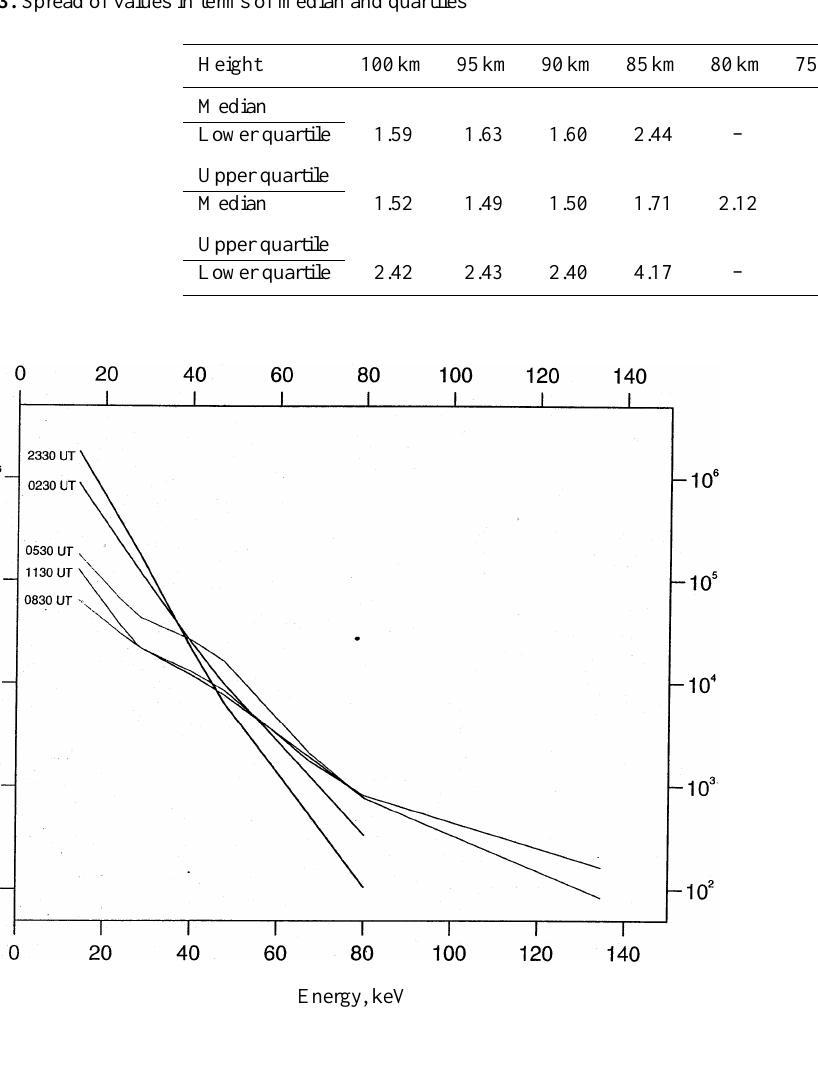
Table 2. Numbers of electron-density values and of zeros in the data set Height 100km 95km 90km 85km 80km 75km 70km Number of electron density values 4295 4282 4149 3300 1968 870 244 Number of zeros 1 14 147 996 2328 3426 4152 % of zeros 0.02 0.33 94